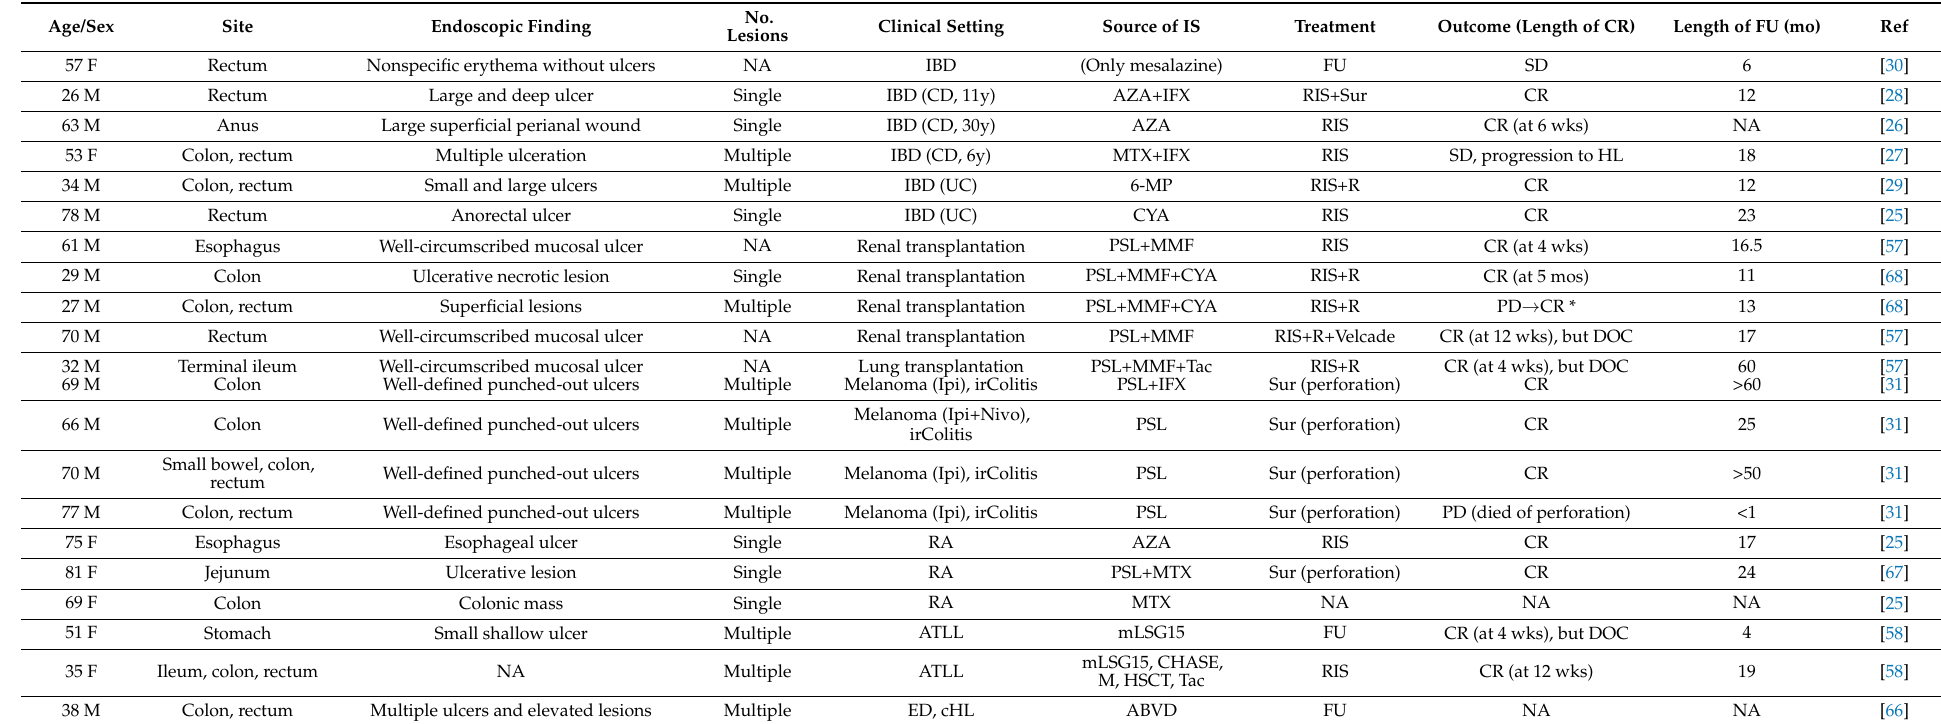
Table 1. Summary of reported cases of EBVMCU of the GI tract (n =